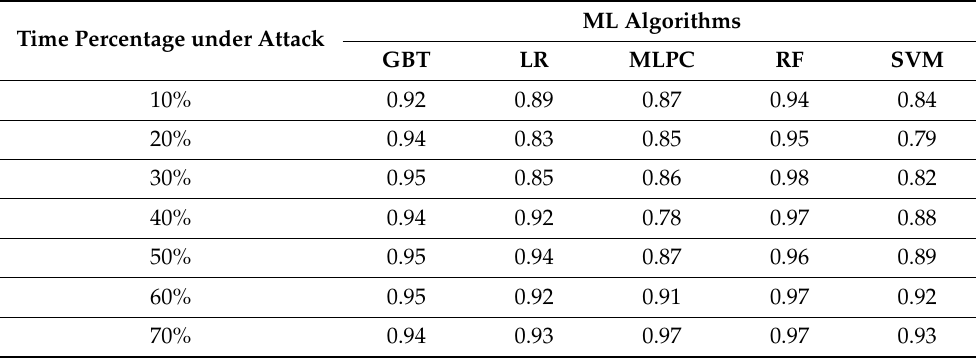
Table 4. Model Accuracy result of the networks